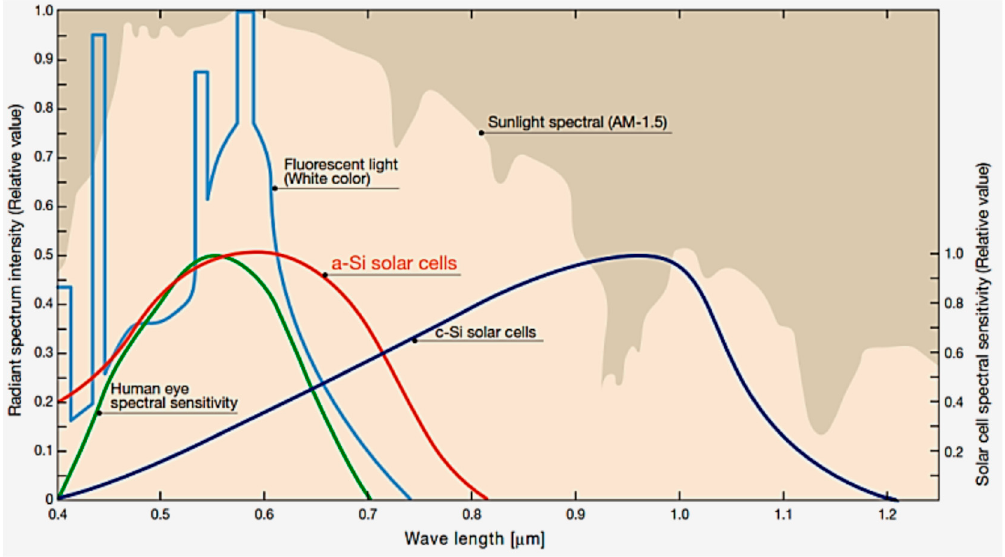
Figure 5. Comparison of relative radiant spectra of sunlight vs. artificial light from incandescent bulbs and fluorescent lamps.